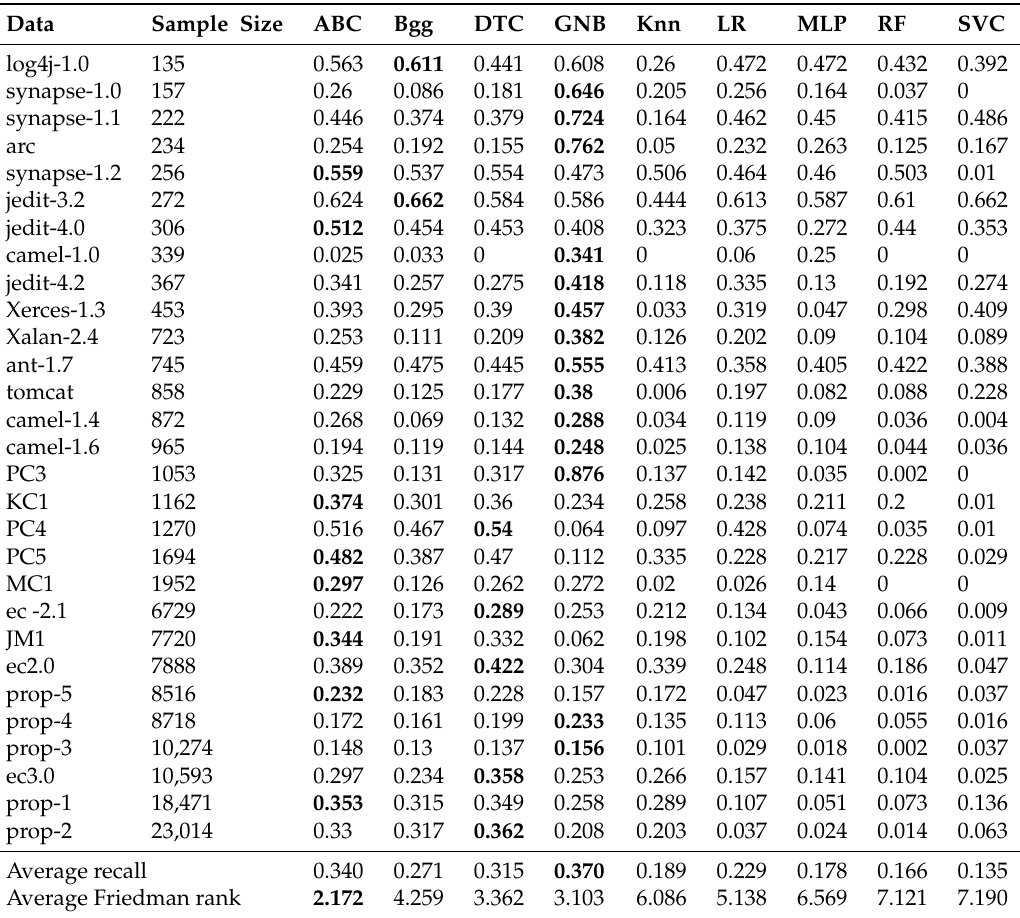
Figure 4. Average Friedman rank value of 3 metrics for 9 classifiers. Table 4. Recall of comparison among basic classifiers.